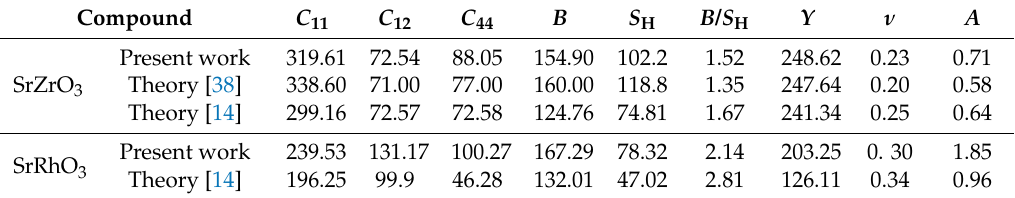
Table 3. Calculated elastic constants of SrTMO 3 (TM = Rh,